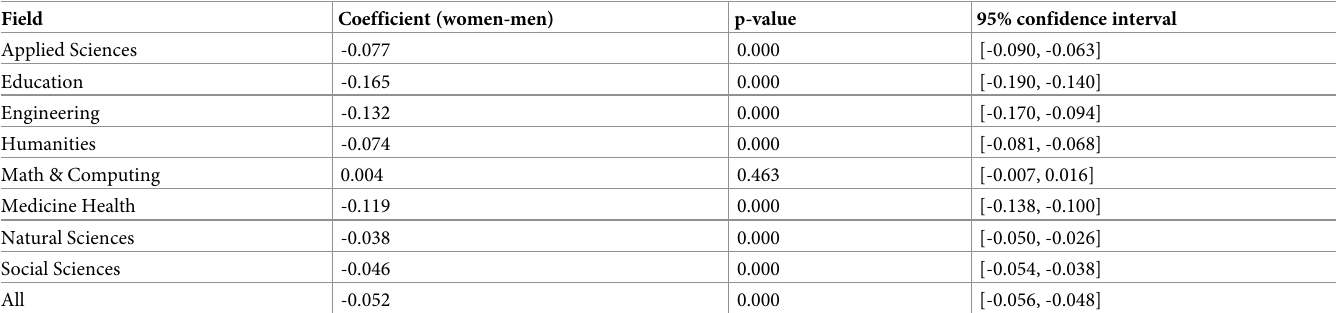
Table 5. Regression results for ratings by